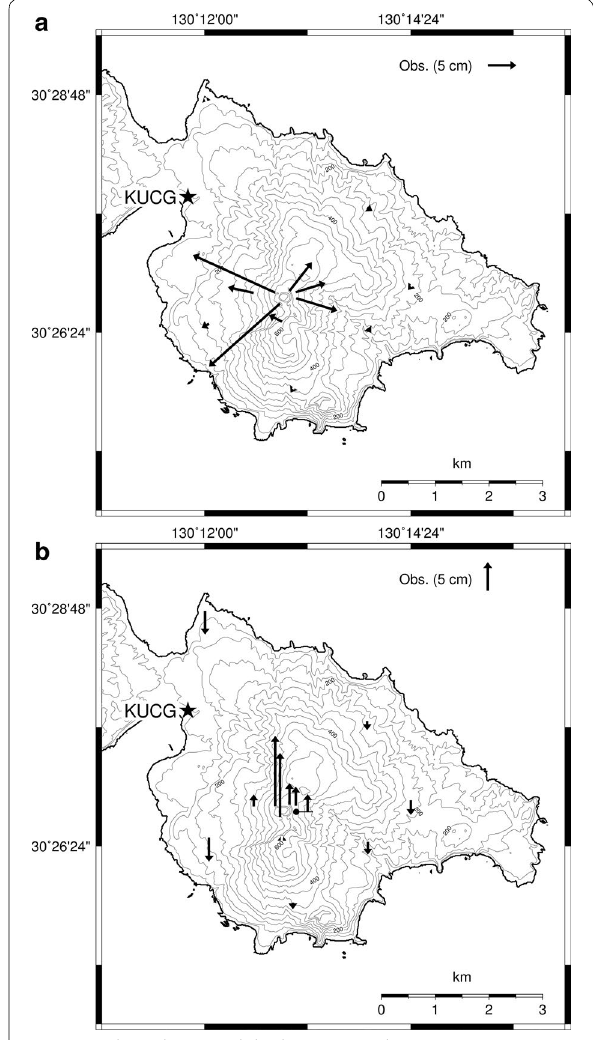
Fig. 4 a Relative horizontal displacement with respect to KUCG during January 2006–April 2014. b Same as a for relative vertical displacement with respect to